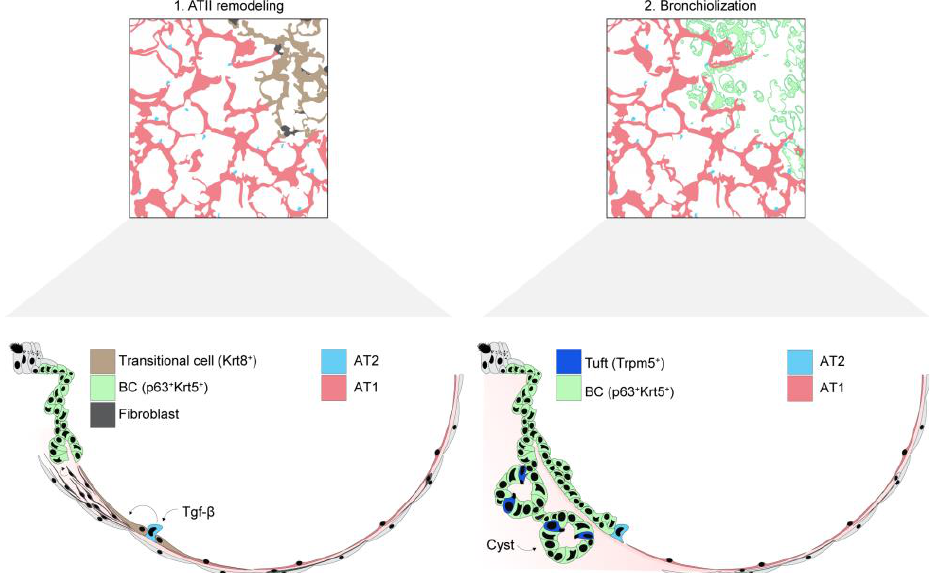
Figure 3. Alveolar epithelial responses that determine maladaptive lung remodeling. Schematic representations 1 – 2 represent proposed mechanisms of maladaptive lung remodeling after injury. (1) Inappropriately sustained TGF β signaling blocks AT2-to-AT1 cell transdifferentiation, leading to accumulation of Krt8-expressing transitional cells. The presence of these cells is associated with the development of pulmonary fibrosis. (2) Basal-like cells (BCs) expand after injury to promote barrier recovery after extreme injuries. In the process, basal-like cell pods emerge at sites of damaged alveoli and form cystic structures. Tuft cells are found near BCs, but their functional significance is not yet clear.